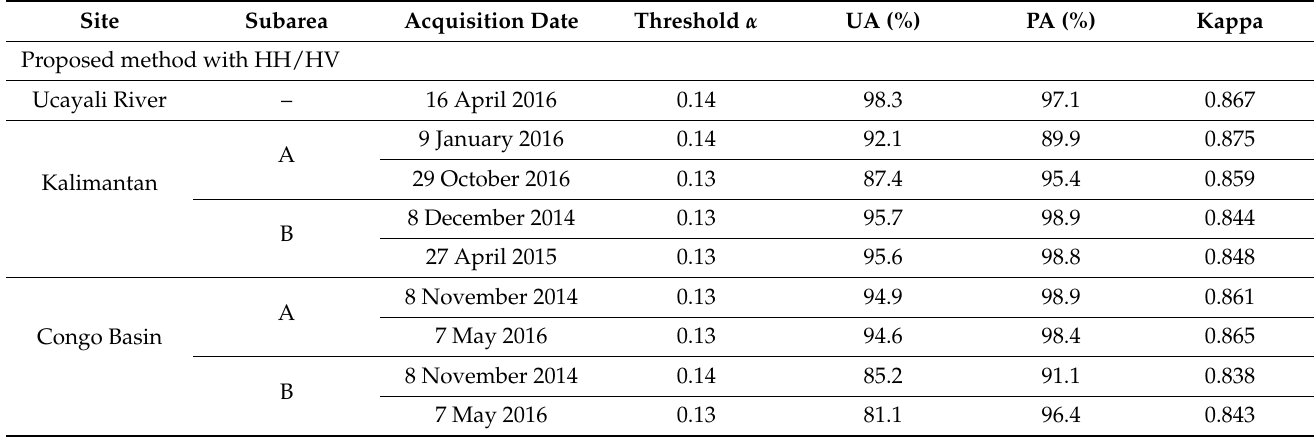
Table 6. Consistency between the proposed method and 6SD method using a window size of 10 × 20 pixels at Ucayali River, Kalimantan, and the Congo